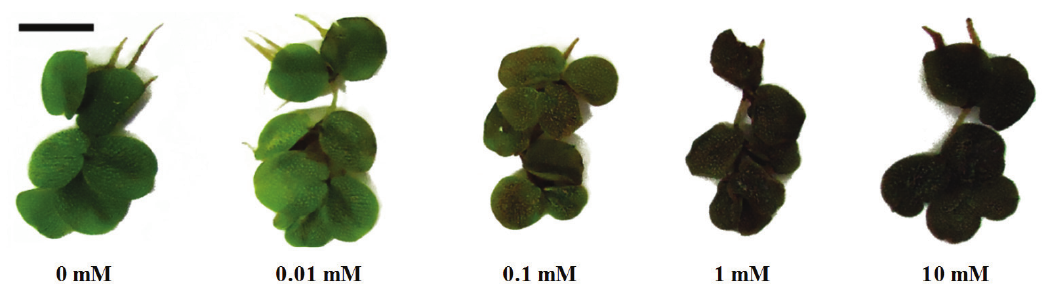
Figure 1. Plants of Salvinia auriculata Aubl. exposed to Cu. The horizontal bar equals 1